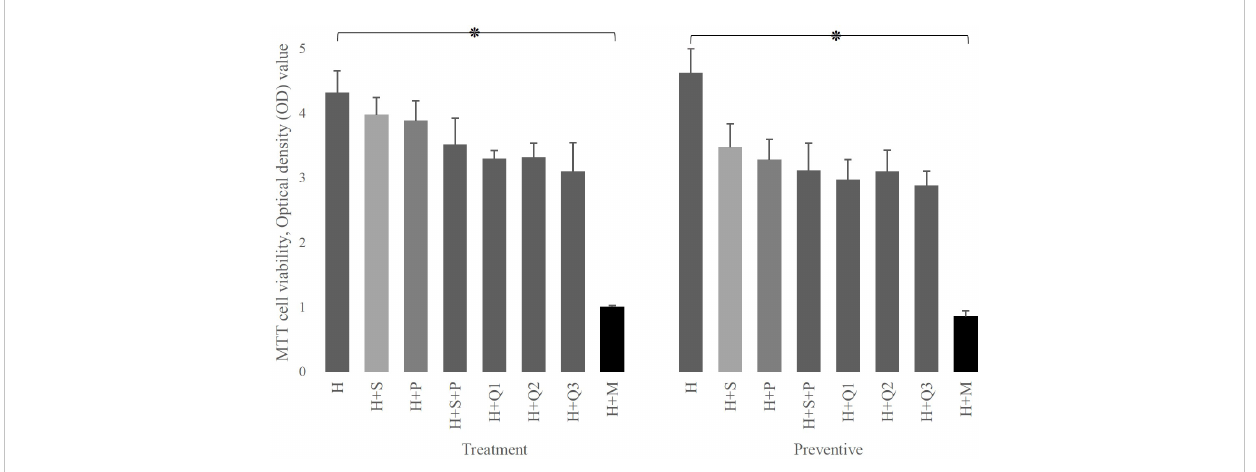
FIGURE 2 The effect of P ( L. plantarum ), S (L. salivarius ), and M ( S. mutans) on the viability of H (HEp-2 cell) in treatment and preventive mode. As shown, the presence of any of the substances used in this study (different doses of Q10 or probiotics) either immediately (therapeutic settings) or after 3 hours (preventive settings) by itself does not have a destructive effect on HEp-2 cells, while the presence of mutans strongly affects the survival of these cells. The values are the mean ± SD of these assays. Asterisk (*) indicates a signi fi cant difference (p-value<0.05) in the values when compared to the